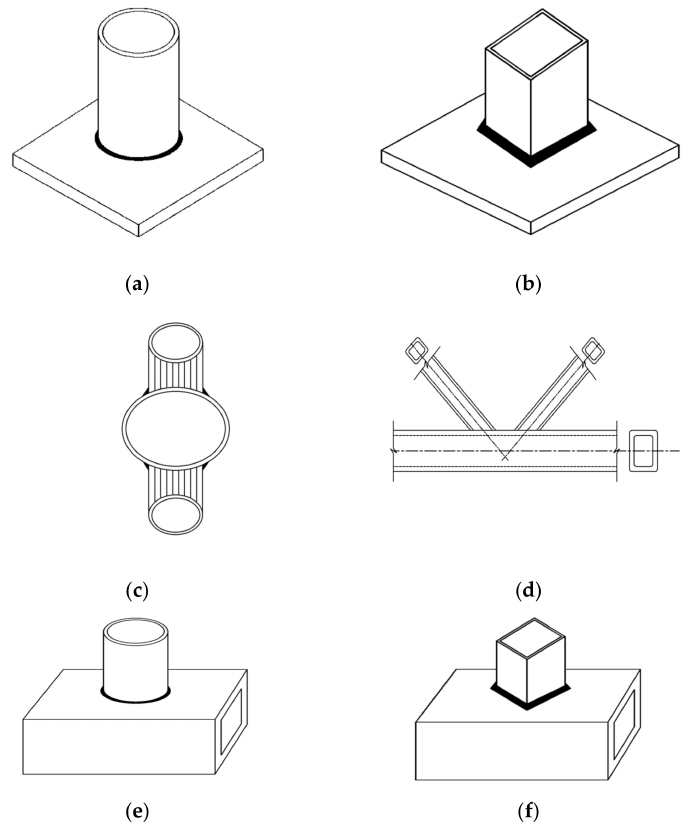
Figure 10. Various fillet welded joint connections on hollow sections. ( a ) CHS-to-plate connection; ( b ) SHS-to-plate connection; ( c ) CHS-to-CHS X-connection; ( d ) RHS-to-RHS K-connection; ( e ) CHS- to-SHS T-connection; ( f ) SHS-to-SHS